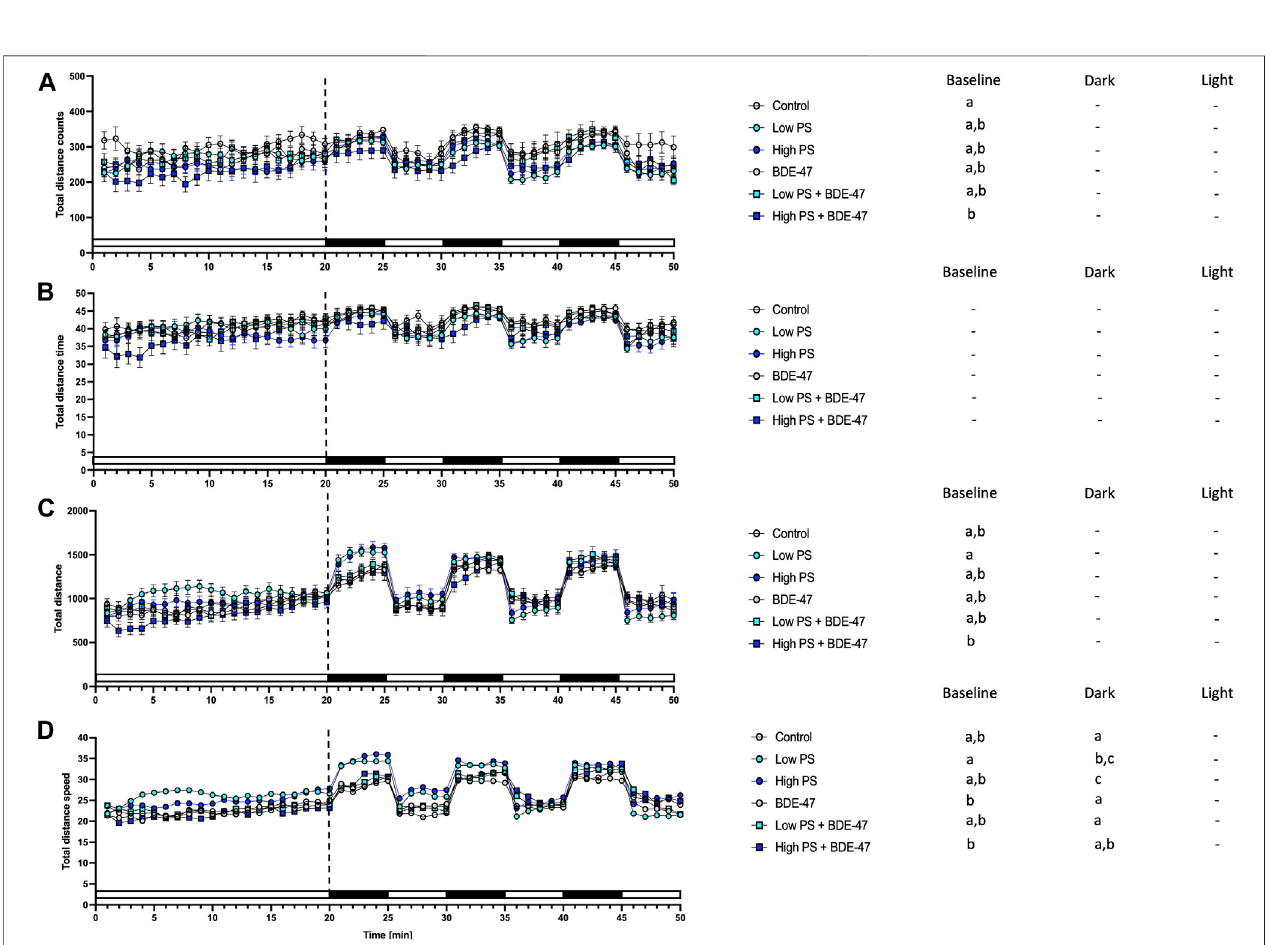
FIGURE 6 | Total movement parameters from 7 dpf zebra fi sh larvae locomotion assays ( n = 3) with a total n = 48 per treatment group consisting of exposures to vehicle control, 2.5 ppm PS, 25 ppm PS, 10 ppt BDE-47 or their combinations. All measurements over the 50 min assays were binned in 1 min units, with 20 min baseline followed by 3 cycles of 5 min dark light alterations. Average total counts of movement events +/ − S.E.M. (A) , average duration of total movement events +/ − S.E.M in s (B) , Distance of total movement events +/ − S.E.M in mm (C) , Average speed +/ − S.E.M of total movements in mm/s (D) . Data were analyzed using separate one-way repeated measurement ANOVAs for baseline, dark, and light conditions. Signi fi cant treatment effects ( p < 0.05) are shown in Table 2 , and speci fi c post-hocanalysisresultsaredepictednexttothegraphsforallparameters.Differentlettersindicatesigni fi cantdifferencesbetweengroupsasanalyzedbyTukey ’ spost- hoc test ( p <